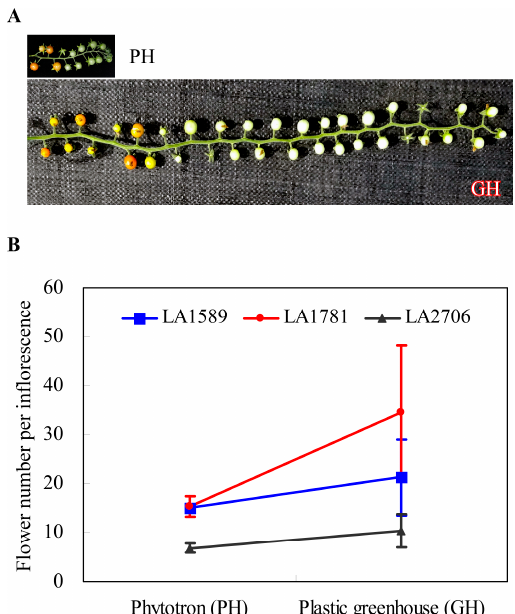
Figure 1. Plasticity of inflorescence development observed in three tomato accessions. ( A ) representative images showing plasticity of inflorescence development in Solanum pimpinellifolium LA1781. Inflorescences of LA1781 plants grown in a plastic greenhouse (GH) were much longer and harbored more flowers, compared to those of phytotron (PH) plants. The inflorescence (lower panel) was from three-months-old GH plants transplanted in mid-March 2016; ( B ) variations in plasticity of inflorescence development measured by flower number in LA1589, LA1781 and LA2706 (Moneymaker). Flower numbers were counted on 30–60 inflorescences of at least 10 (PH) or 30 (GH) plants. Data are represented by mean ± standard deviations (SD).